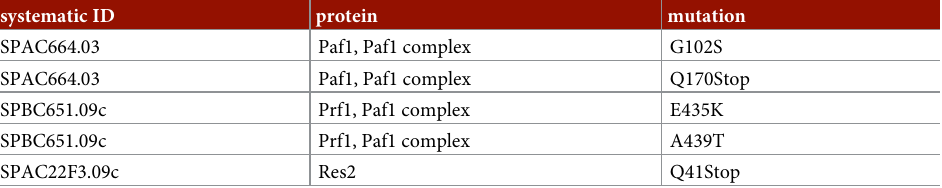
Table 1. Anticipated genes with mutations mapped by whole-genome